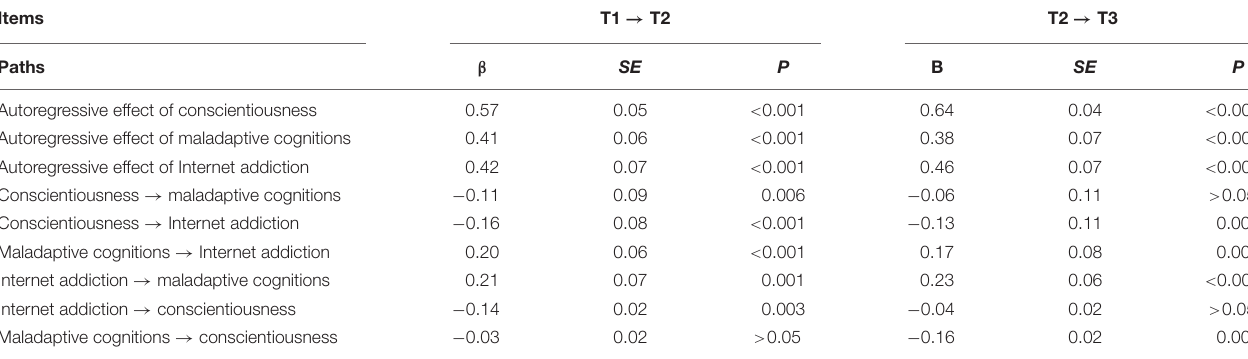
TABLE 7 | Regression coefficients of cross-lagged associations among neuroticism, maladaptive cognitions, and Internet addiction within M4. Items T1 → T2 T2 → T3 Paths β SE P B P Autoregressive effect of neuroticism < 0.001 Autoregressive effect of maladaptive cognitions Autoregressive effect of Internet